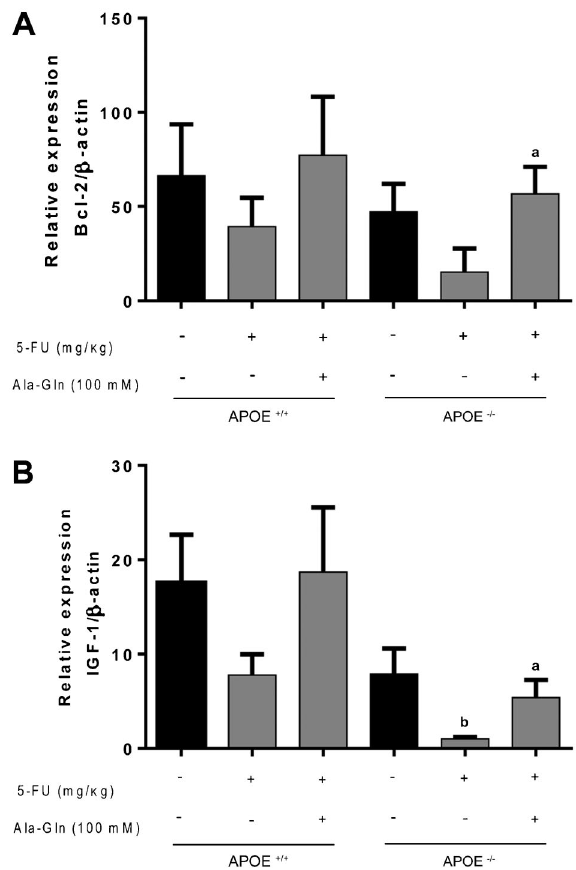
Figure 5. Quantitative real-time PCR for B-cell lymphoma 2 (Bcl-2) and insulin-like growth factor-1 (IGF-1) mRNA transcripts from C57BL6J ApoE-knockout (APOE -/- ) and wild-type (APOE +/++ ) mice challenged by 5-fluorouracil (5-FU)-induced intestinal mucositis (450 mg/kg, ip , singledose) on theday6 post-challengeandtreated with alanyl-glutamine (Ala-Gln, 100 mM) or phosphate buffered saline (PBS, control) via gavage. Data are reported as means±SEM. a P , 0.05 vs 5-FU-challenged group. b P , 0.05 vs unchallenged control (one-way ANOVA and the Bonferroni